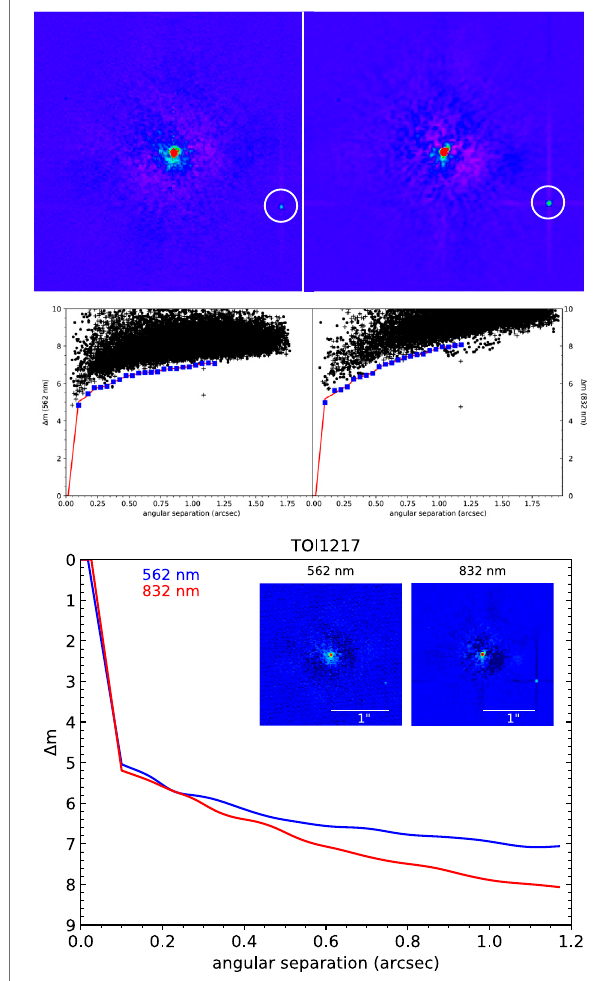
FIGURE 4 | The reduced data products provided to users for TOI 1217. At the top are the fi nal reconstructed images for the 562 and 832 nm observations ( left and right , respectively). For clarity, the detected companion is circled in these images. In the middle row are the respective detection contrast limit curves. The curves here represent the 5 σ detection limit and the detected companion is evident as the “ + ” symbol located below the detection limit. At the bottom is a fi nal plot provided as part of the data reduction compositingthereconstructedimages, scale,and5 σ contrastcurvesforboth fi